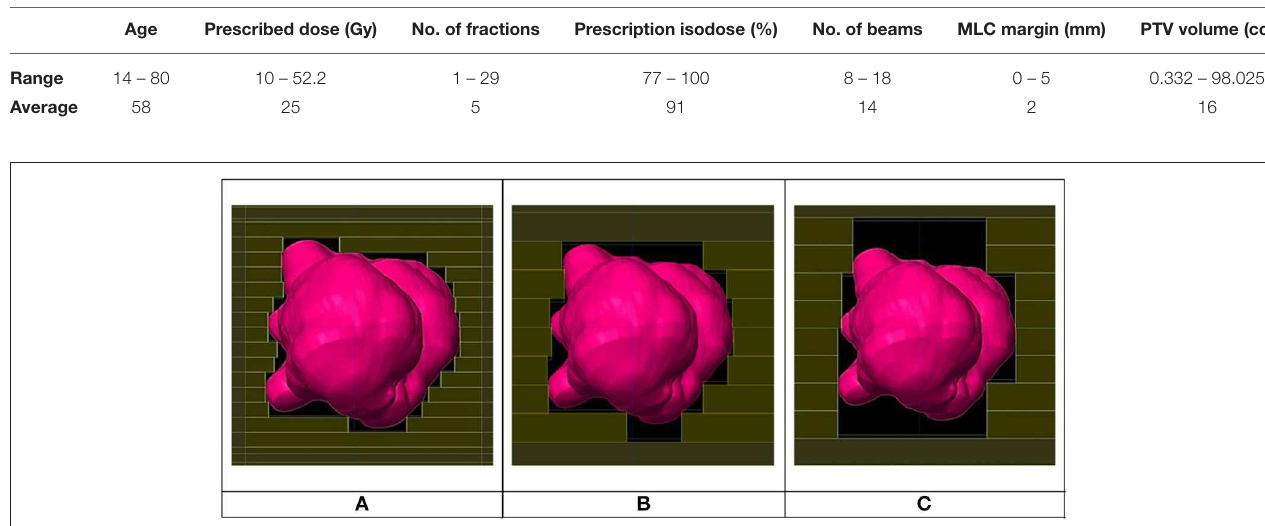
TABLE 1 | Patients and treatment plan characteristics as originally treated.